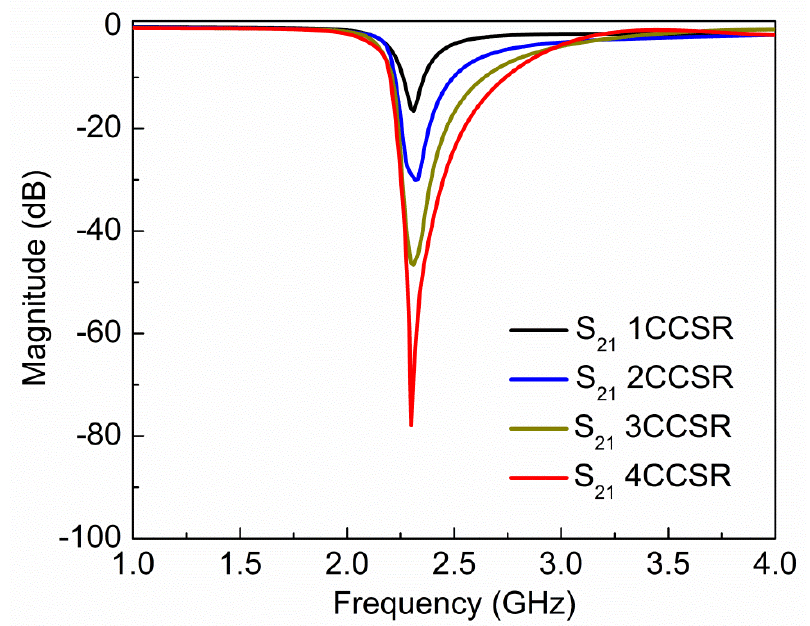
Figure 6. Simulated transmission coefficient of proposed sensor with one, two, three, and four complementary circular spiral resonator (CCSR) in the ground plane separated 1 mm apart. By increasing number of CCSR in the ground plane, notch depth and bandwidth increase but resonance frequency remains the same.